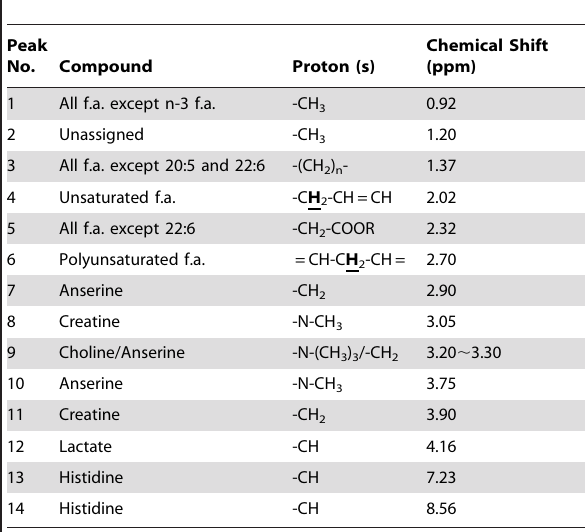
Table 1. Peak assignment for iMQC spectrum of intact muscle tissue from Atlantic salmon.